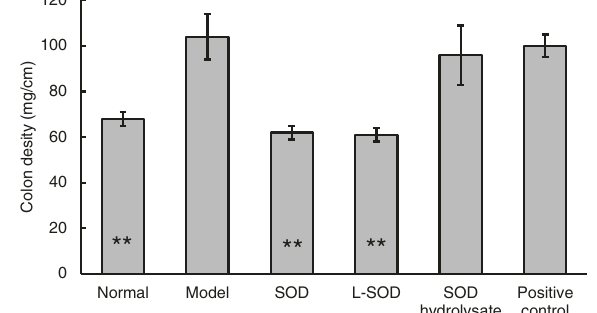
Fig. 5 Colon density in rats after 4-week intervention. The data are presented as mean ± SD, n = 6 each group. * P < 0.05, ** P < 0.01 vs. model